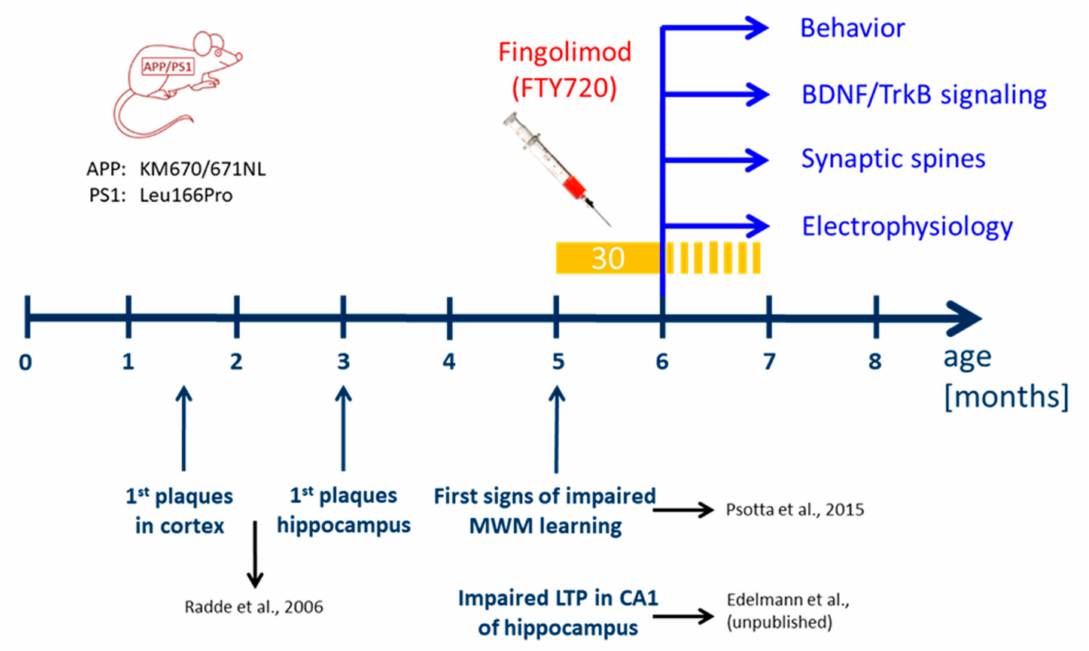
Figure 1. Time line of treatment with fingolimod (FTY720) compared to development of Alzheimer’s disease (AD)-like pathology in the amyloid precursor protein / presenilin-1 (APP / PS1) mouse model used in the study. Mutations in APP and presenilin 1 in the APP / PS1 mouse model used in our study are indicated on the left [17]. In these Thy1-promoter-driven APP / PS1 mice, A β plaques are detectable after six weeks in the neocortex and after three months in the hippocampus [17]. Moreover, these APP / PS1 mice show first indications of spatial learning deficits in the Morris water maze (MWM) [19] and impaired long-term potentiation (LTP) at Scha ff er collateral-cornu ammonis-1 (CA1) synapses in the hippocampus (Edelmann et al., data not shown) at five months of age (i.e., starting at 22 weeks). FTY720 injections (every second day; yellow bar) started at five months (no earlier than 22 weeks after birth) when the animals already display synaptic and memory deficits. The injections were carried on for at least 30 days thereafter, and were continued (stippled yellow bar) until completion of behavioral testing, or until animals were sacrificed for analyses (spines, LTP, immunohistological stainings, biochemical brain-derived neurotrophic factor (BDNF) and tropomyosin related kinase B (TrkB) signaling analysis) at six to seven